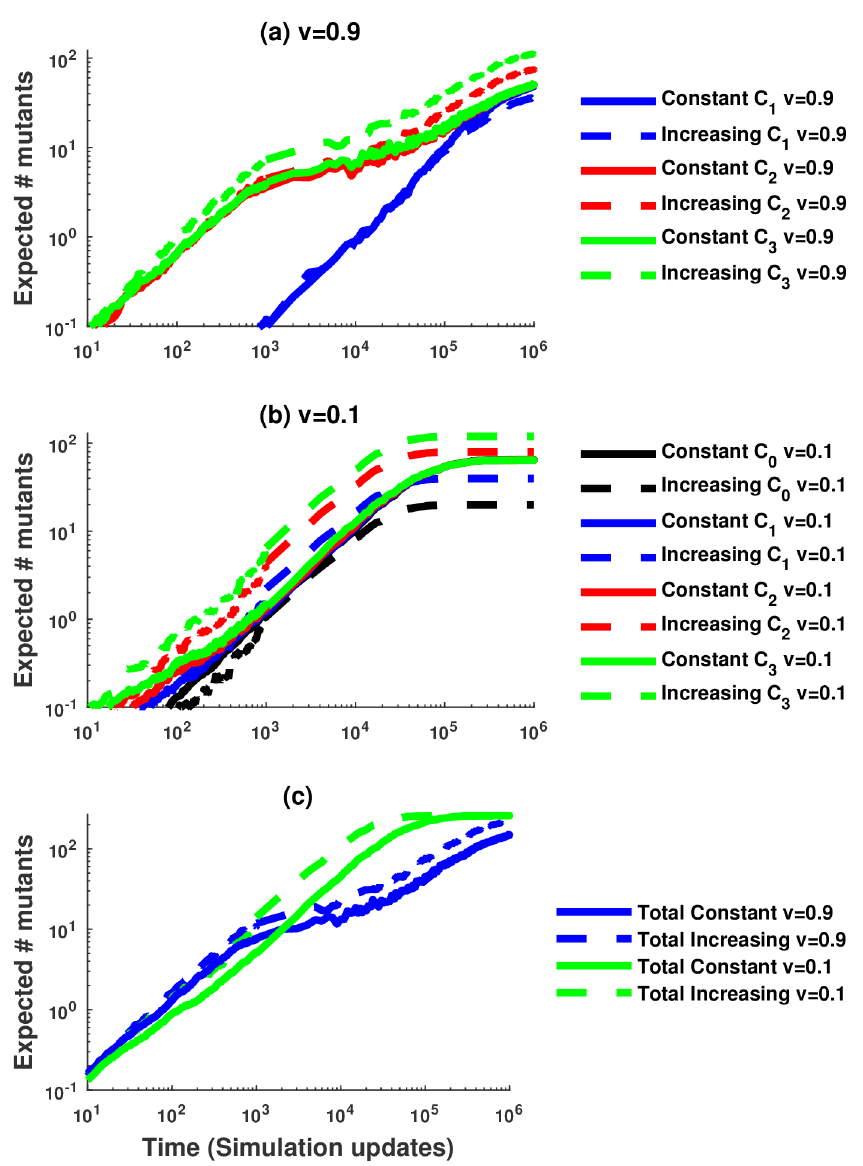
Fig 5. Mean number of mutants from 1000 stochastic simulations. We compare two arrangements of the compartment sizes for n = 3: constant from C 0 to C 3 ( N 0 = 65, N 1 = 65, N 2 = 65, N 3 = 65) and increasing from C 0 to C 3 ( N 0 = 20, N 1 = 40, N 2 = 80, N 3 = 120). (a) The mean number of mutants produced in compartments C 1 , C 2 and C 3 for v = 0.9. Note that no mutants were produced in compartment C 0 over the time scale shown. (b) The mean number of mutants produced in compartments C 0 , C 1 , C 2 and C 3 for v = 0.1. (c) The mean of the total number of mutants comparing both architectures for v = 0.9 (blue line) and v = 0.1 (green line). For all panels, solid lines correspond to constant architecture and dashed lines to increasing architecture. In these simulations u =